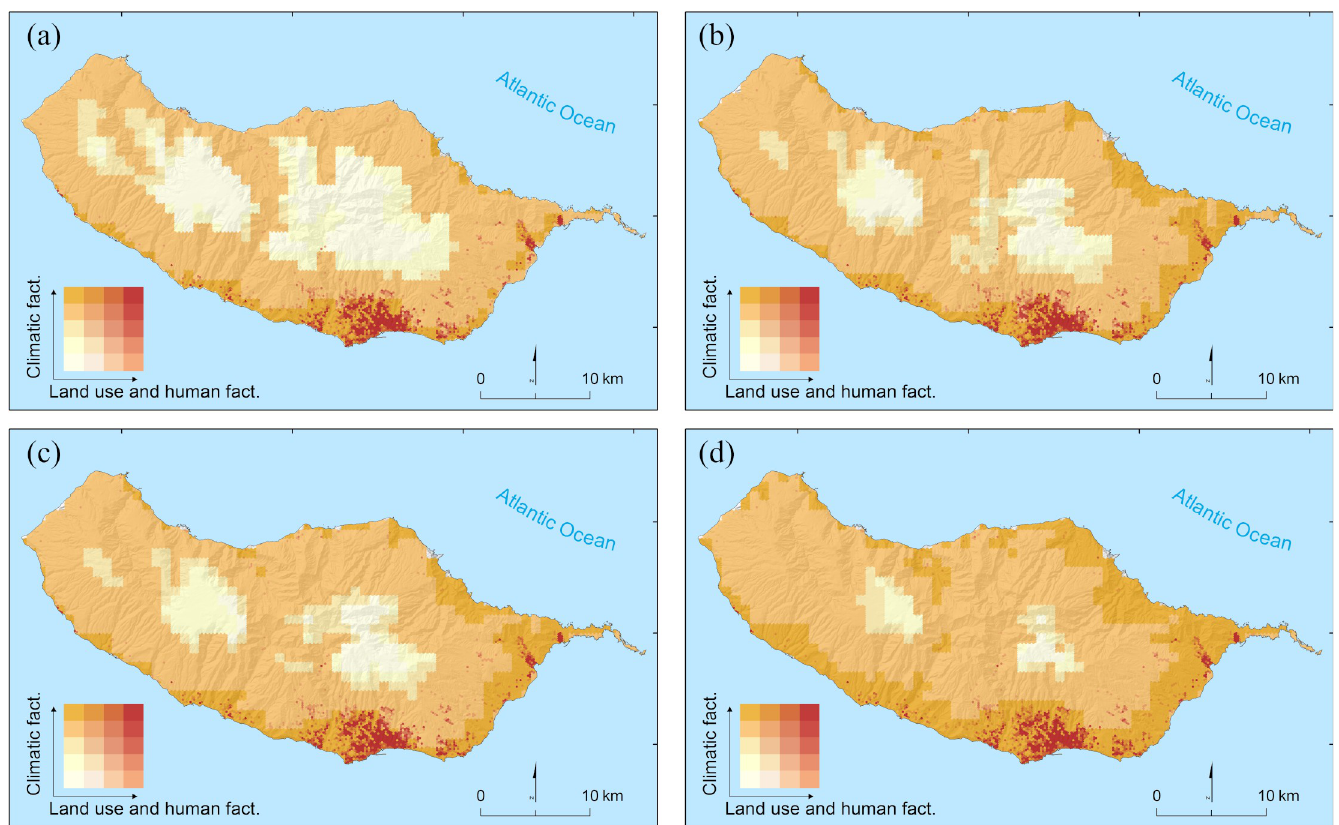
Fig 7. Suitability of climatic and of human-related or land use conditions for Aedes aegypti on Madeira Island. Inter-model consensus on suitable conditions for each set of factors is represented along a bivariate gradient, where darker (lighter) colors on each axis represent higher (lower) consensus on suitable conditions. Estimates of climatic suitability are provided for current conditions (a) and the mid of the 21st century (2041–2060) under RCP2.6 (b), RCP4.5 (c) and RCP8.5 (d) (source of shapefile: https://www.dgterritorio.gov.pt/cartografia/cartografia-tematica/caop).